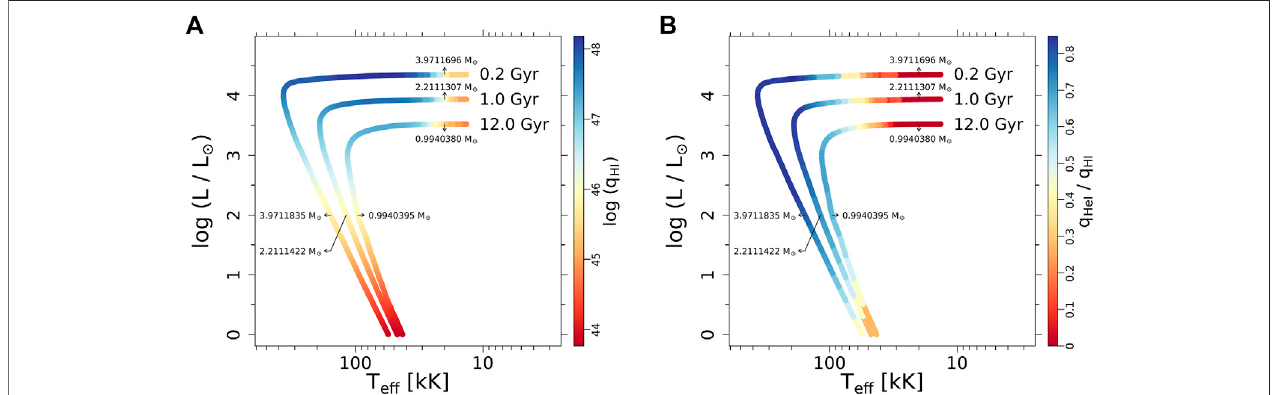
FIGURE 3 | Isochrones in the luminosity vs . effective temperature plane for stellar populations with 0.2, 1.0 and 12 Gyr and solar metallicity. The points along the isochronesarecolour-codedaccordingtotheirlogq HI (A) andq HeI /q HI ratio (B) ,whereq HI andq HeI aretheH I andHe I ionizingphotonratesinunitsofs − 1 .Themasses of stars in twodifferent points along each isochrone are indicated; the mass difference between thesepoints ison the order of10 – 5 and 10 – 6 M ⊙ for the populations with 0.2 and 12 Gyr, respectively.